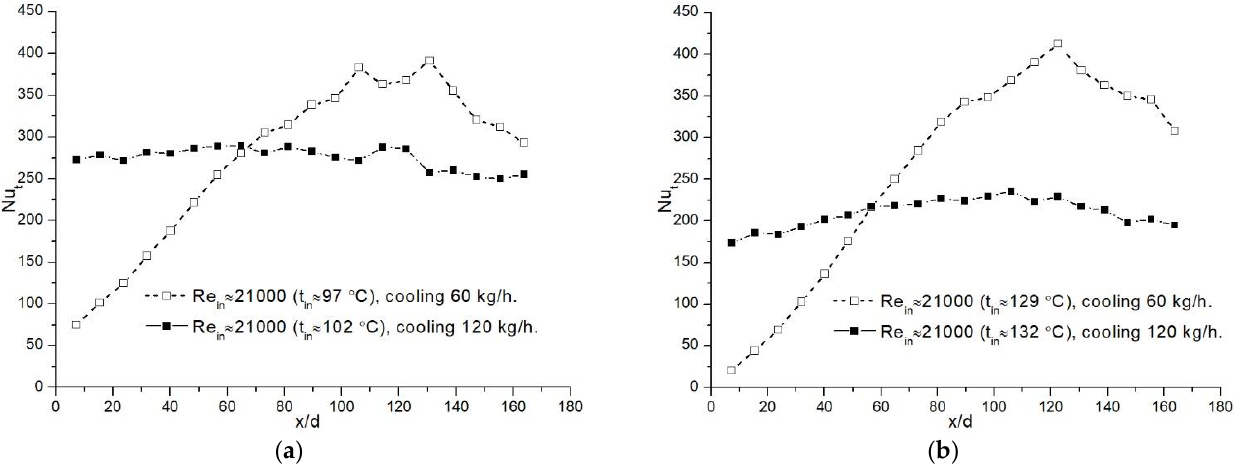
Figure 6. Distribution of the local Nu t in the heat exchanger at Re in ≈ 21000, at different flue gas inlet temperatures (smaller ( a ), higher ( b )) as well as cooling water flow